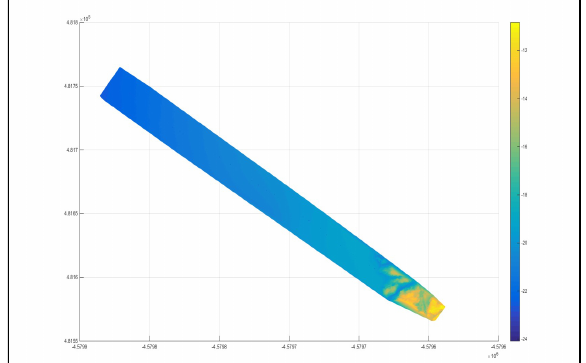
Figure 4. swath plot(X-Y view)